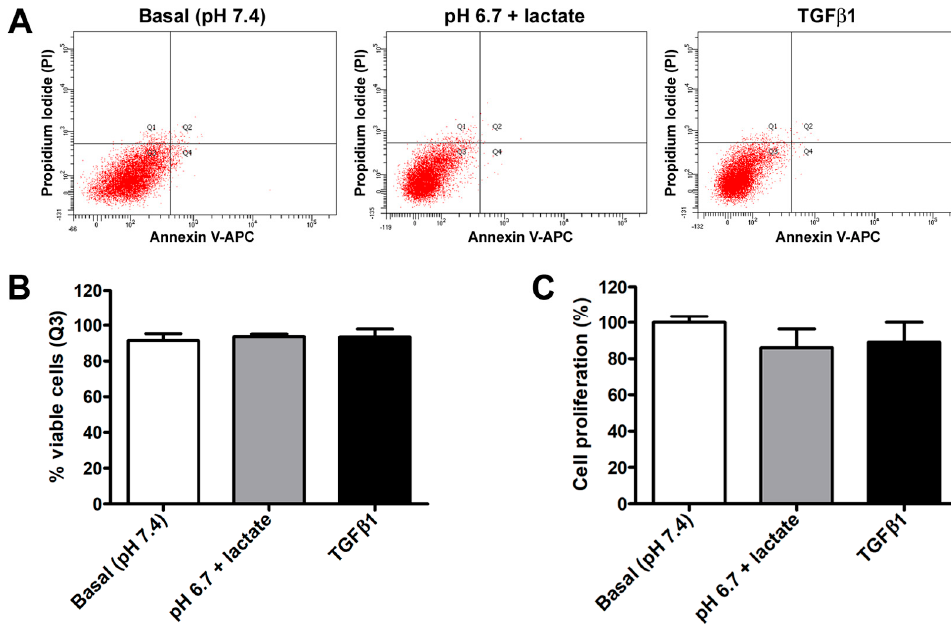
Figure 2. Representative flow cytometer plots of annexin V/propidium iodide (PI) staining ( A ) with cell viability quantification ( B ), and proliferation chart ( C ) of adipocyte-committed adipose-derived stem cells (acADSCs) cultured for 3 days under basal conditions (pH 7.4), lactic acidosis (pH 6.7 + lactate), or in the presence of 10 ng/mL TGF β 1. Proliferation of acADSCs at basal conditions was set to 100%, and the other results are normalized to this value. Bars represent the mean ± SEM of three independent experiments ( n = 3 replicates each for Annexin V/PI assay, n = 10 replicates each for proliferation assay) from three cell lines. No statistical difference among the three experimental groups was detected for both percentages of viable cells ( B ) and cell proliferation ( C ) by one-way ANOVA.